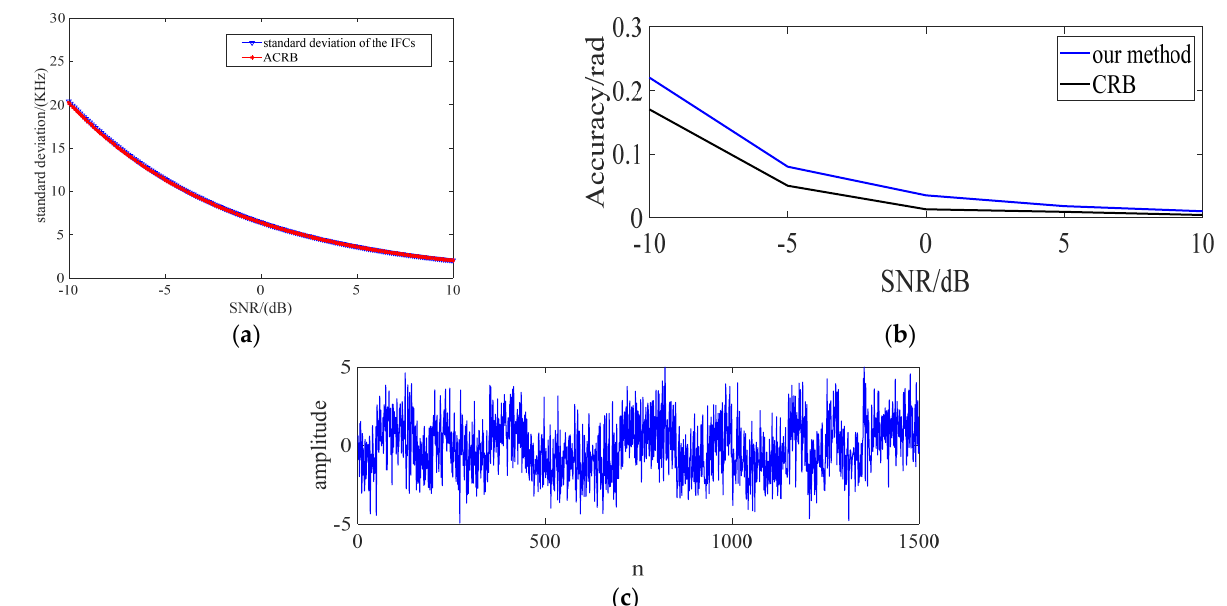
Figure 8. Results of the pretreatment: ( a ) standard deviations of estimated frequency; ( b ) standard deviations of estimated initial phase; ( c ) the ZIF signal after pretreatment under SNR = − 5 dB. The simulation results of the NCTVR with different SNRs are shown in Figure 9.